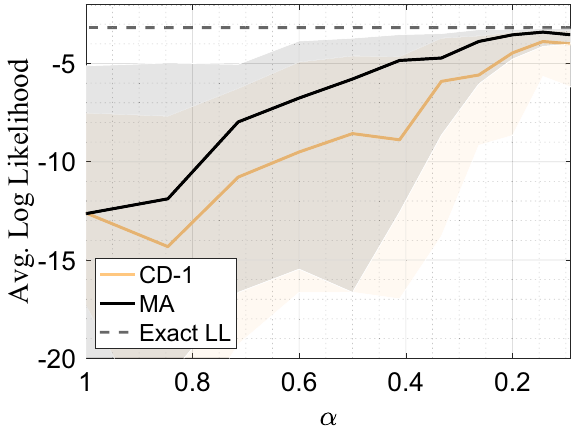
Figure 3. Average Log-Likelihood achieved on an n v = 24 dimensional shifting bar data set as a function of DBM shape, α . The total number of hidden nodes are kept fixed at n h ( 1 ) + n h ( 2 ) = 22 . An ensemble of 50 DBMs were trained with CD-1 and MA, where the solid line shows the median average log-likelihood achieved after 10 5 gradient iterations with a linearly decaying learning rate ǫ = 1 → 0.01 , and shaded regions delineate the 95th and 5th